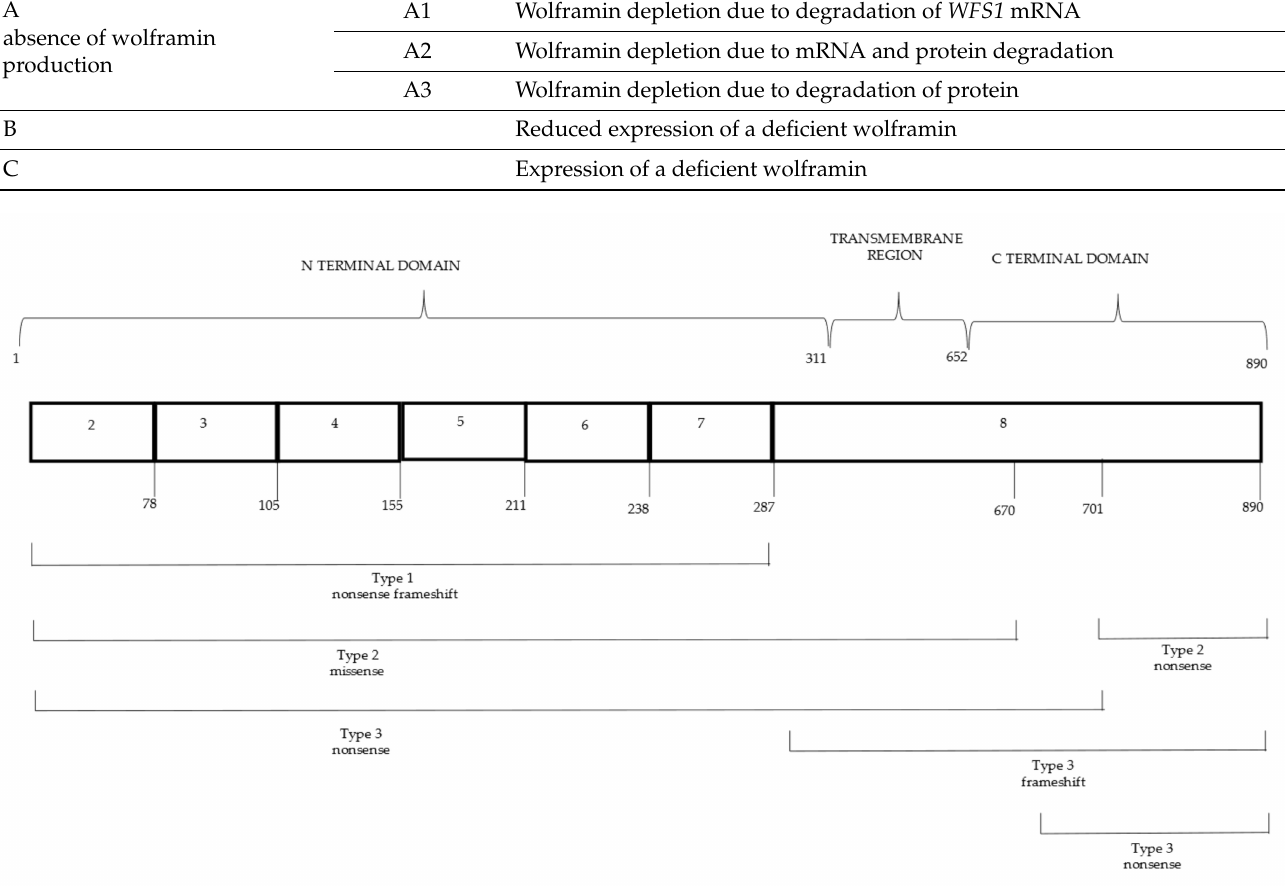
Figure 1. Genotypic classification of WFSI